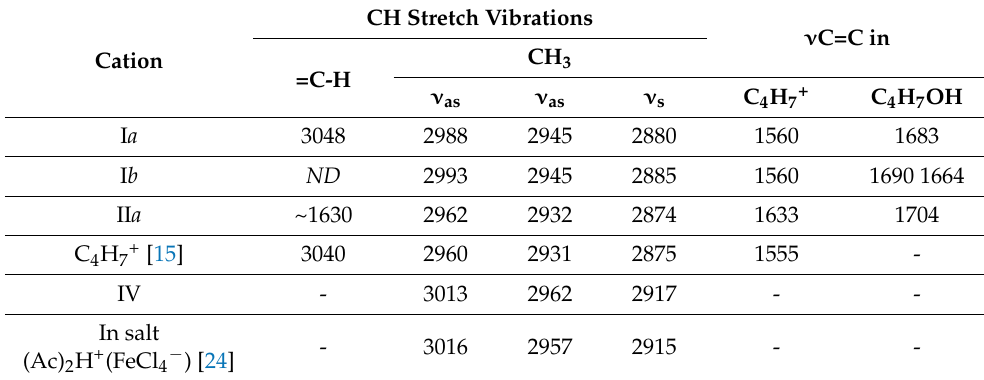
Figure 4. ATR IR spectra (with ATR correction) of crystals of salts of cations Ia (red) and Ib (blue). Anion signals are marked with asterisks. Table 2. CH and C=C stretch frequencies (in cm − 1 ) of the vinyl cation in adducts I–IV and in (Ac) 2 H + .